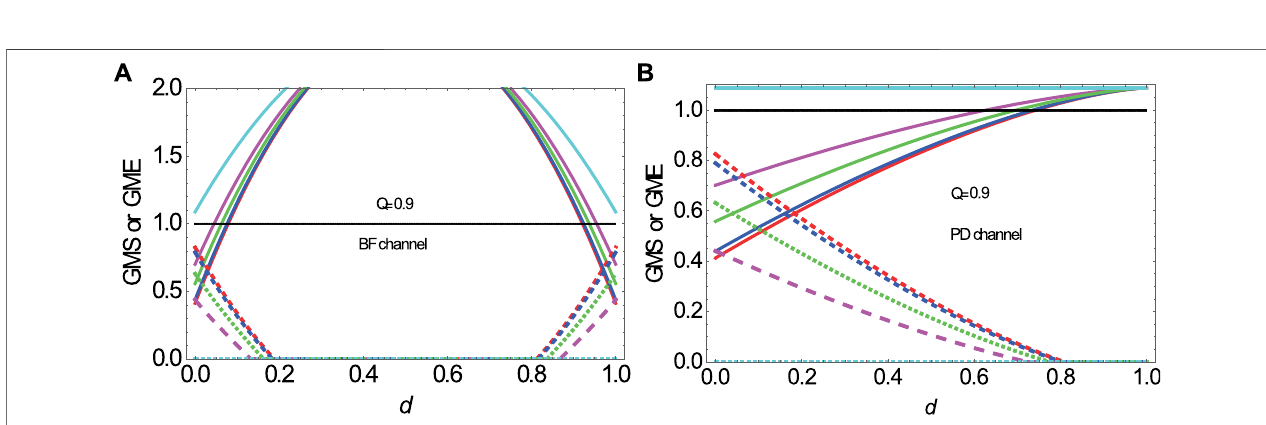
FIGURE 8 | (Color online) Variety of quantum measures (GME (dashed line) and GMS (solid line)) as a function of channel-noise factor d in terms of different state parameters α for Q (cid:2) 0 . 9. (A) shows the BF channel, and (B) shows the PD channel. Here, α (cid:2) lines), and α (cid:2) 1 (cyan